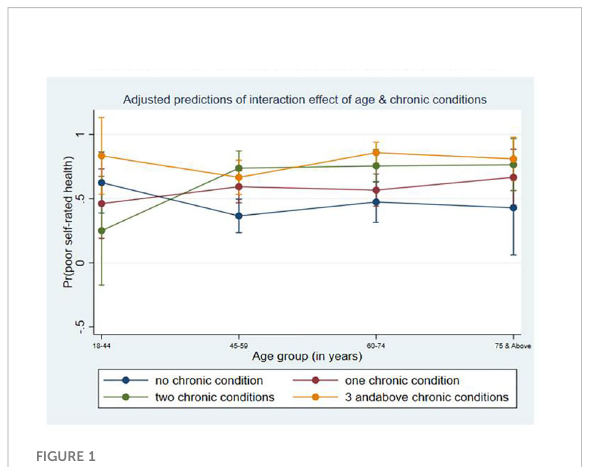
FIGURE 1 Adjusted prediction interaction effect of age and chronic